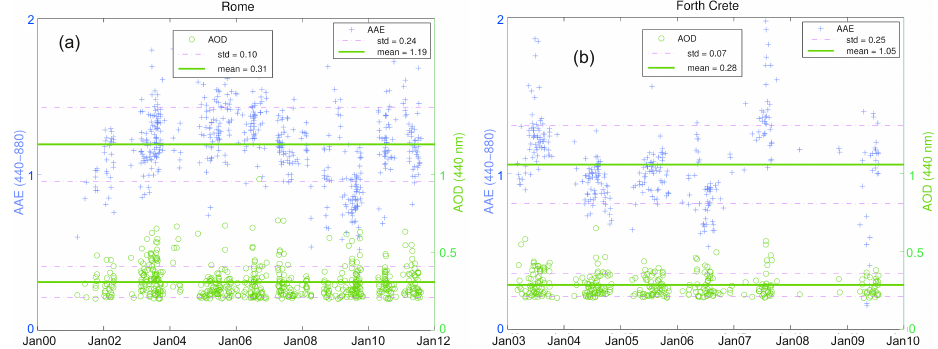
Fig. 10. AAE (calculated between 440 and 870nm) and AOD (440nm) estimated from AERONET Level 1.5 data for Rome (a) and Crete (b) AERONET sites. Mean values and standard deviations are